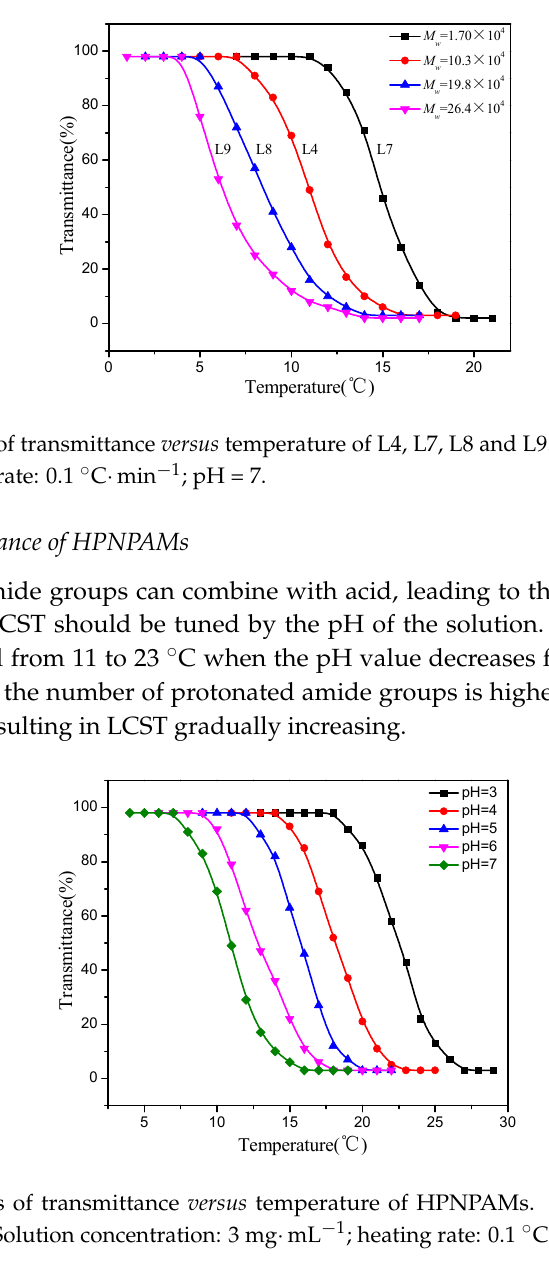
Figure 7. Photographs of an aqueous solution of L2. 5 °C ( left ) and 25 °C ( right ); HBU: Hebei Figure 7. University.